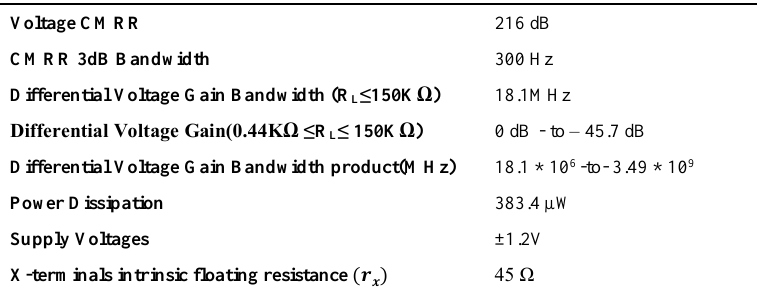
Table 2. CMIA's performance specifications.